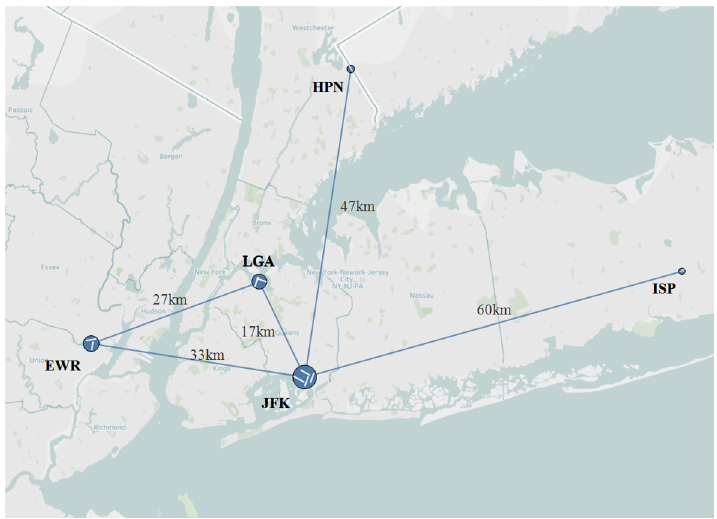
Figure 5. The New York MAR.